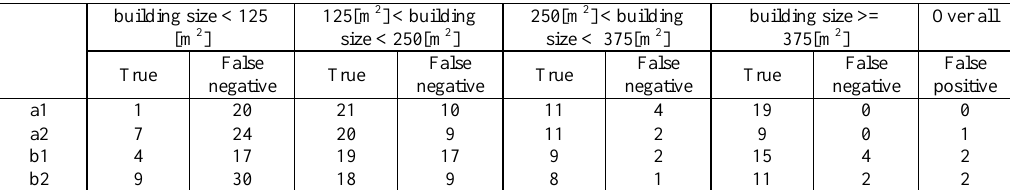
Table 1. Object based evaluation of the building footprints.